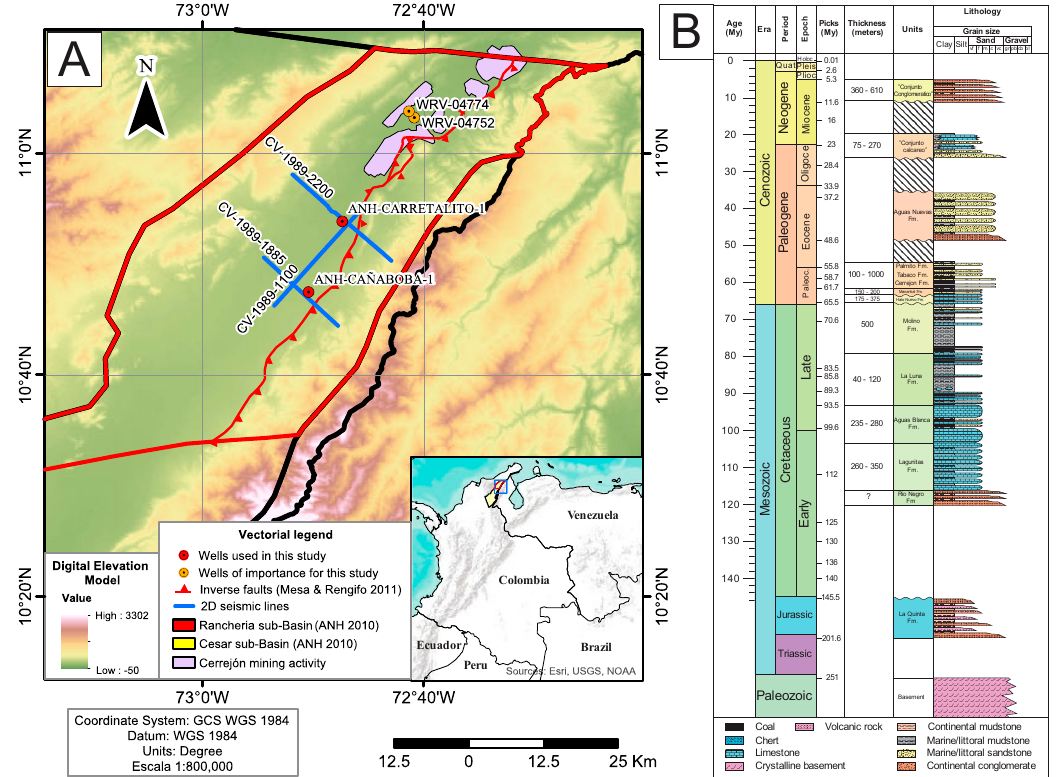
Figure 1. ( A ) Map with the location of the Rancher í a Basin, Colombia (yellow area). Locations of the Rancher í a Sub-Basin (red bold lines), studied wells ANH-CARRETALITO-1 and ANH-CAÑABOBA-1 (red dots), and seismic lines (bold blue lines) are present, with the major fault system and the Cerrejón mining activity area. ( B ) The generalized stratigraphic column of the Ranchería Sub-Basin is taken from Mesa and Rengifo [1].